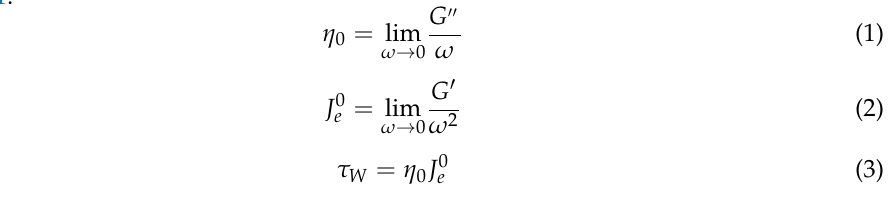
Table 1. Rheological parameters of pure